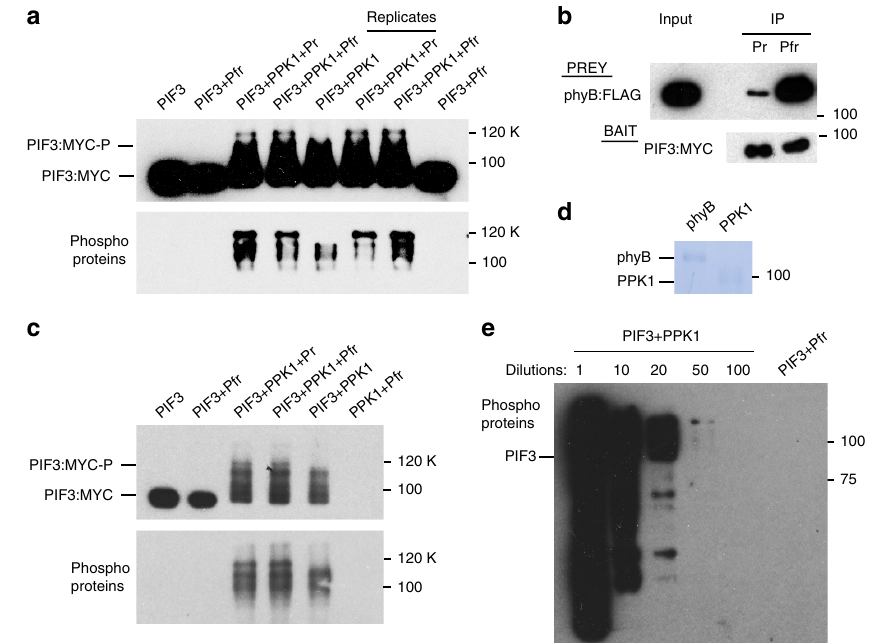
Figure 6 | phyB stimulates PPK1-catalysed PIF3-phosphorylation in a non-light-dependent manner in vitro but does not detectably autonomously phosphorylate PIF3. ( a ) Mobility-shift (upper panel) and pIMAGO (lower panel) assays detect differential PPK1-catalysed phosphorylation of PIF3 in vitro . In vitro protein kinase reactions containing the protein combinations indicated were performed, followed by detection of the PIF3:MYC fusion protein by immunoblot, using anti-MYC antibodies (upper panel), and detection of phosphoproteins using pIMAGO-biotin on immunoblots (lower panel). Pr or Pfr indicate inclusion of the inactive or active conformer of phyB, respectively. Replicates indicate biological replicates of the kinase assays. ( b ) The functional activity of phyB-Pfr was verified using an established in vitro pull-down assay with PIF3 as bait. The immunoblot was probed with an MYC (for PIF3 bait) or FLAG (for phyB prey) antibody. ( c ) Detection of PPK1-catalysed PIF3, and potential phyB, phosphorylation in vitro using mobility-shift (upper panel) and pIMAGO (lower panel) assays as in a . ( d ) Comassie staining of phyB and PPK1 proteins used in the kinase assays in a . ( e ) PPK1 kinase activity is at least 50-fold greater than any potential intrinsic phyB kinase activity. Phosphoproteins from the in vitro kinase reactions indicated were detected by immunoblot using pIMAGO-biotin. Numbers refer to the fold-dilutions of the PIF3 þ PPK1 in vitro kinase reaction shown in a compared to the undiluted PIF3 þ Pfr reaction.